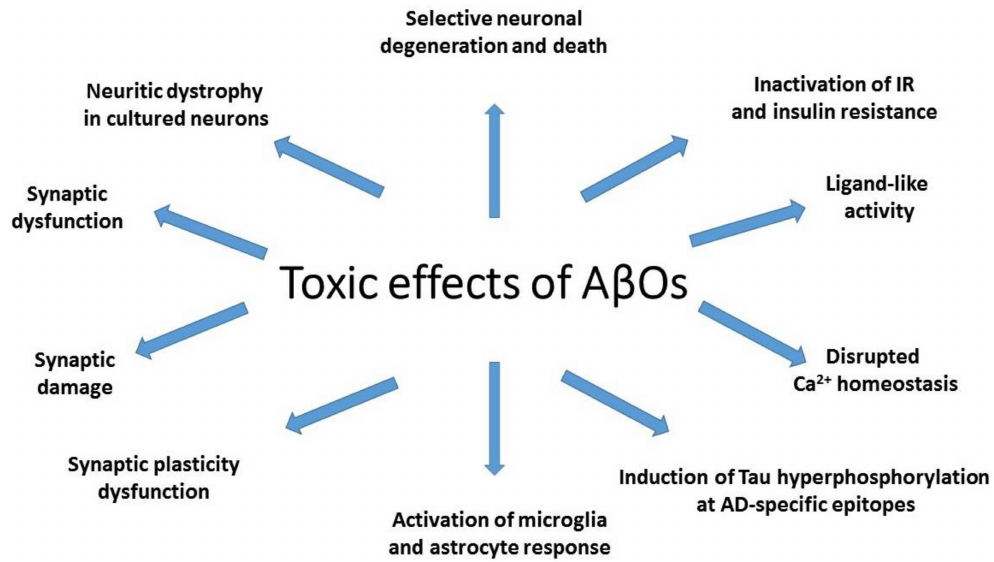
Figure 1. Toxic activity of amyloid β oligomers (A β